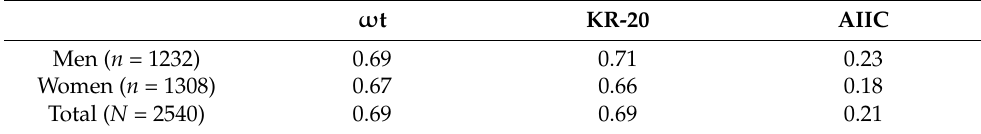
Table 5. Reliability and Homogeneity